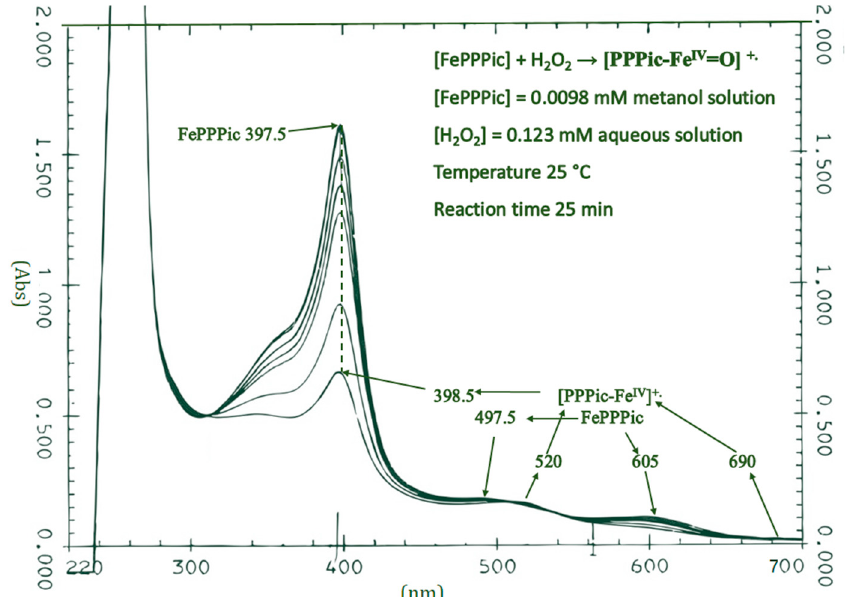
Figure 4. Snapshots of [FePPPic] +. formation observed for 25 min. Soret bands decrease indicating that the [FePPPic] is being auto-oxidized because of the absence of guaiacol in the reaction media, similar to HRP-I (compound I of horseradish peroxidase) behavior in an excess of hydrogen peroxide, which reduces compound I. d - d transitions energetically change showing a new spectrum.